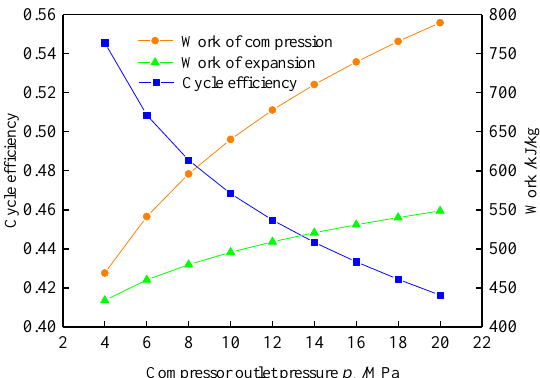
Figure 2. Influence of the compressor outlet pressure ( p 4 L ) on the work of compression, work of expansion, and cycle efficiency.